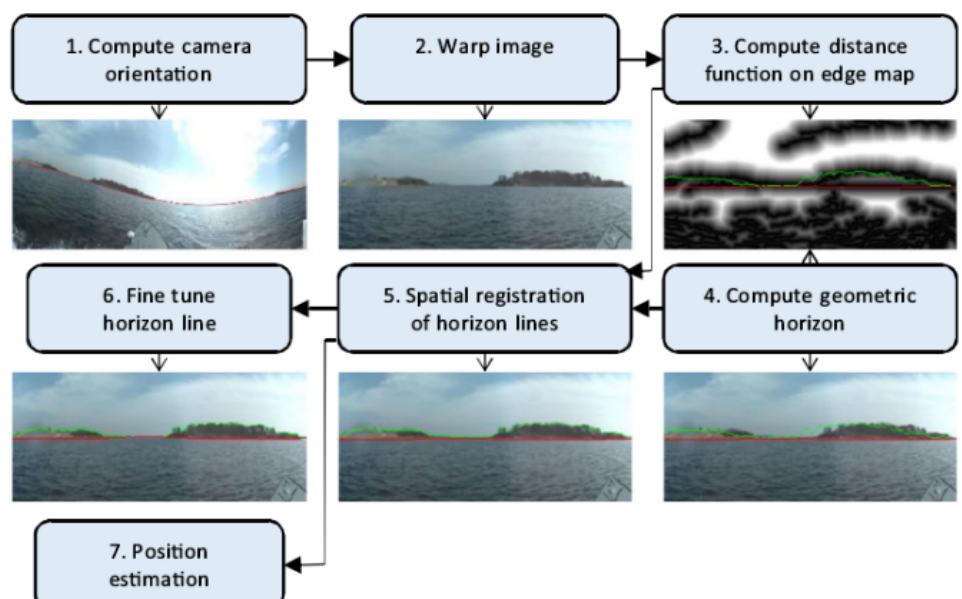
Figure 2. Flowchart of skyline localization of unmanned boat [9]. It can be seen that due to the turbulence of the unmanned boat, the skyline of the original collected image has a large distortion. Through the second step of calibration, the distortion has been corrected.